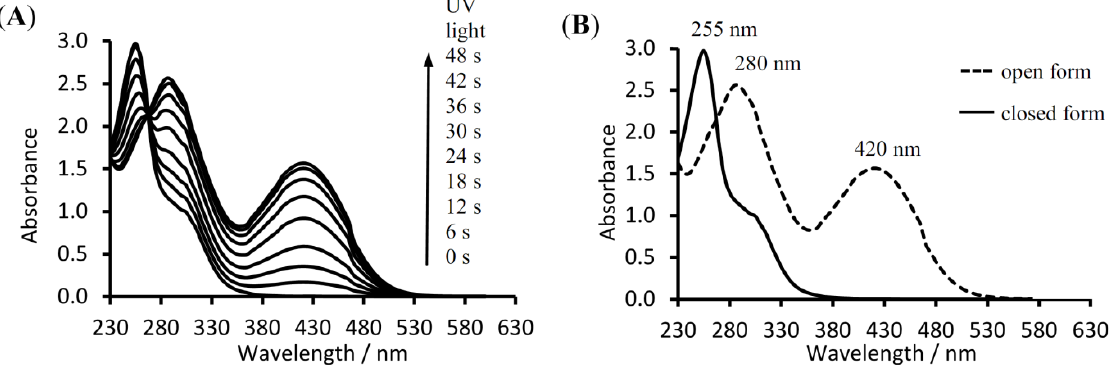
Figure 1. ( A ) Overlay spectra of 4a in dichloromethane (DCM) (3.0 × 10 –4 M) under 365 nm irradiation at ambient temperature; ( B ) UV/Vis spectra of 4a at the same conditions [the solid line ( — ) before and the dashed line ( - - - ) after irradiation for 48 sec at 365